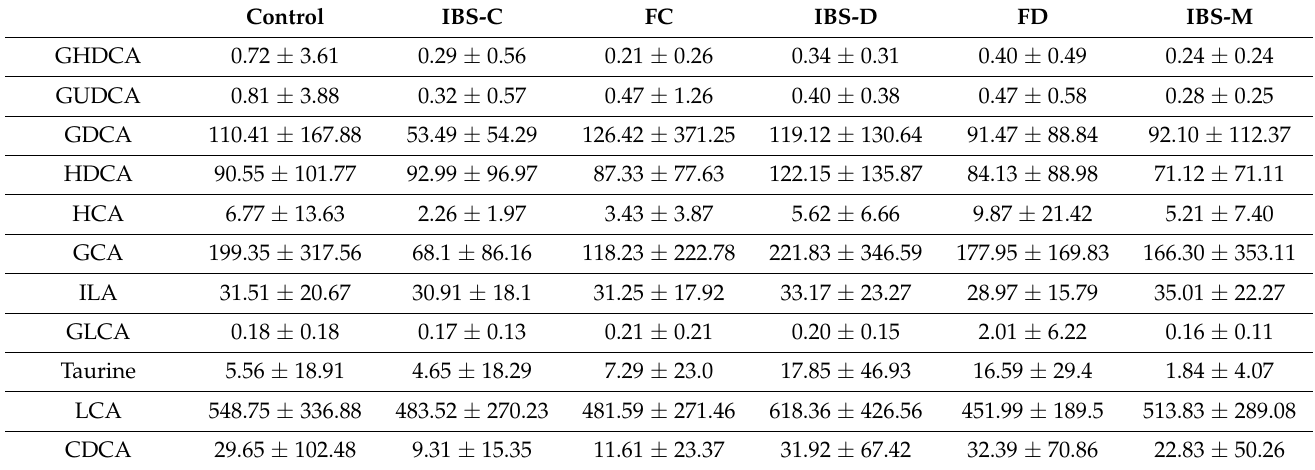
Table A2. Average concentration values of groups for bile acid